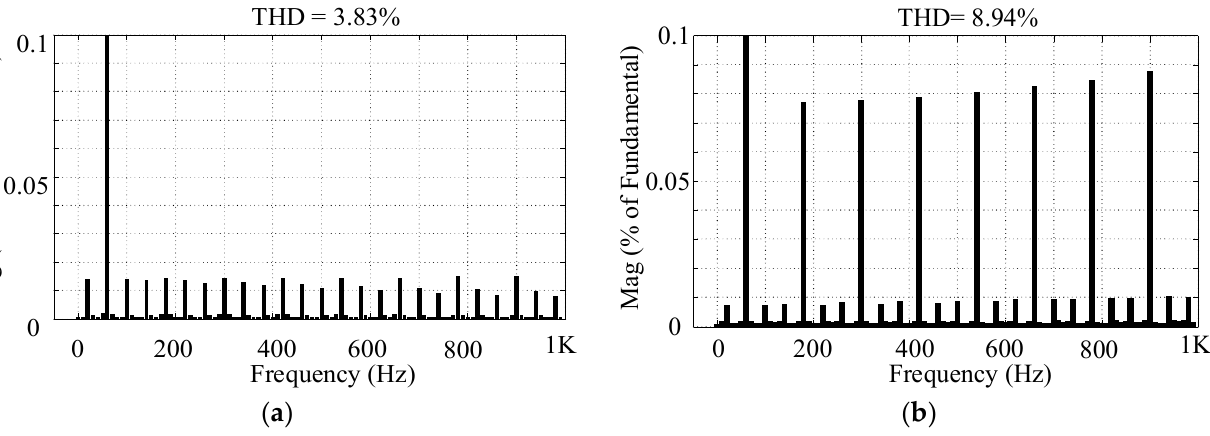
Figure 23. Simulation spectrums of the proposed topology for the buck out-of-phase operating mode when D = 0.78: ( a ) output voltage, ( b ) input current.